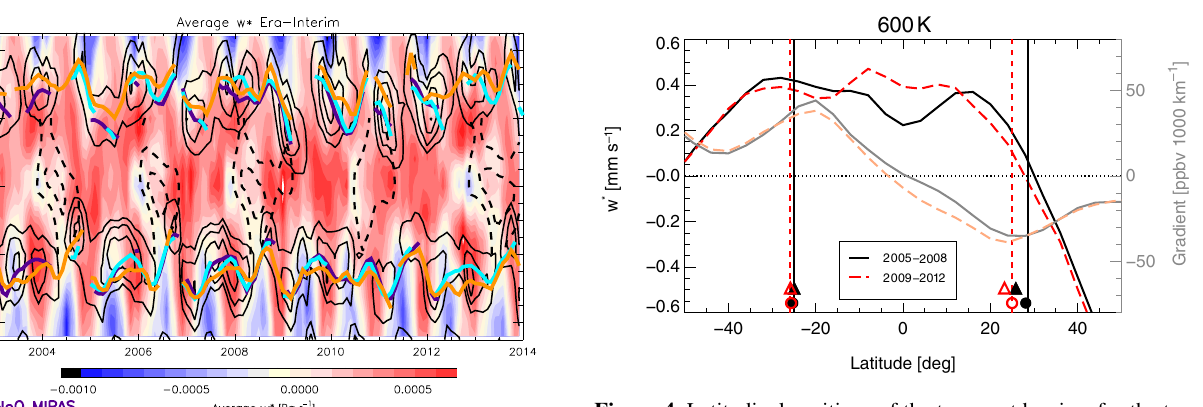
Figure 4. Latitudinal positions of the transport barriers for the two periods I and II at the 600K level; black/grey colours refer to pe- riod I and red/orange colours to period II. Mean w ∗ as function of latitude for the two periods is provided as solid black and dashed red line (left axis); the meridional tracer gradients, representing the gra- dient genesis terms after Miyazaki and Iwasaki (2008) for the two periods are provided as grey and dashed orange lines (right axis). The vertical lines indicate the latitudinal positions of the transport barriers derived from the tracer PDF analysis of CLaMS data, while circles provide the barrier latitudes from the tracer PDF analysis of MLS N 2 O data, and triangles the barrier latitudes from the tracer PDF analysis of MIPAS N 2 O